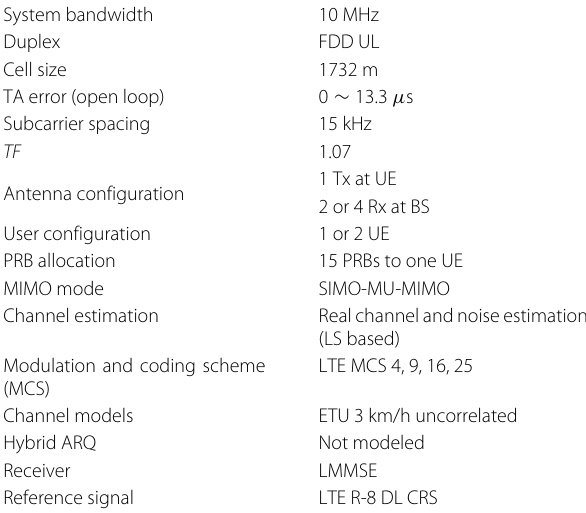
Table 9 Link level simulation for uplink TA-free access